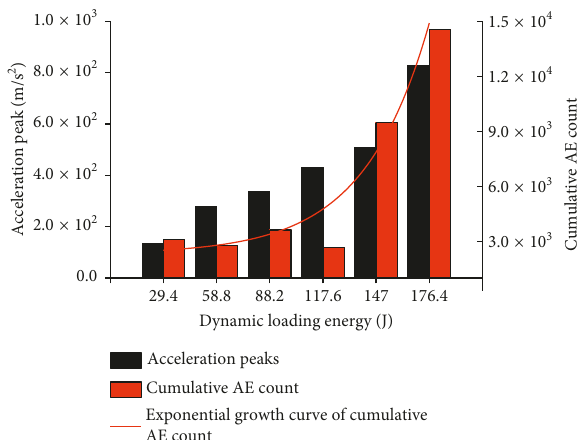
Figure 9: Cumulative AE counts and acceleration peaks at different input energies.